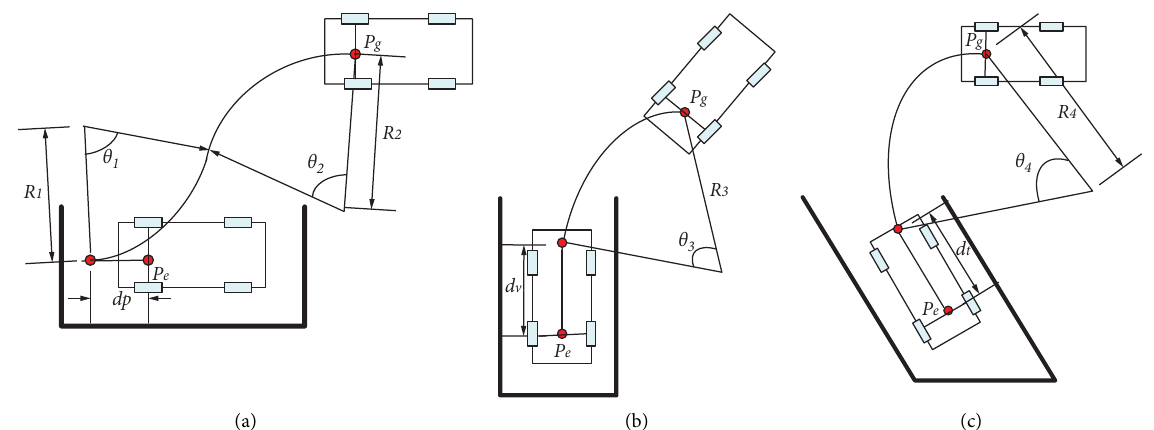
Figure 9: Reverse parking path planning. (a) Parallel parking. (b) Vertical parking. (c) Tilted